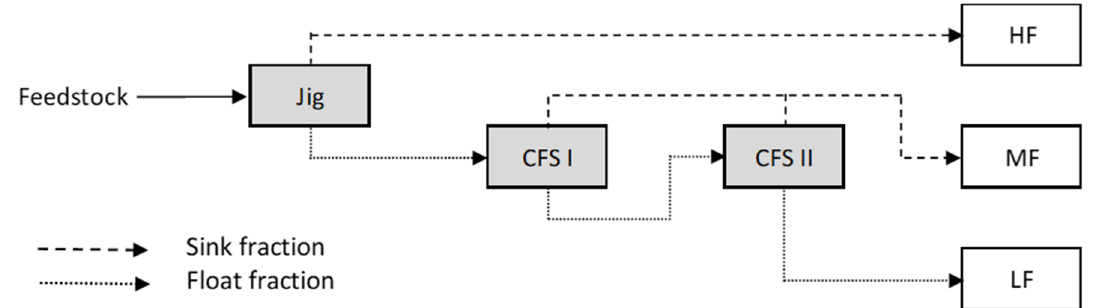
Figure 5. Flow chart of the conducted experiments; CFS I (centrifugal force separator’s first pass), CFS II (centrifugal force separator’s second pass), HF (heavy fraction), MF (middle fraction), and LF (light fraction). Table 12. Mass fraction of the feed (w Feed ), heavy (w HF ) and inter fraction (w IF ) and corresponding polyolefin fraction(w PO ) of the jig for feedstocks with high (A), middle (B), and low (C) initial poly- olefin share.